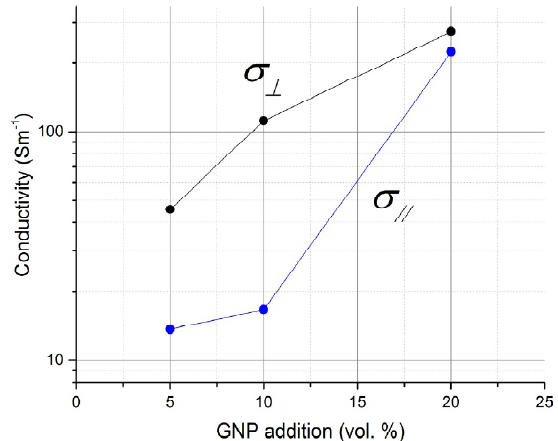
Fig. 7. Illustration of the electrical resistivity anisotropy in the 3YSZ-GNP composites with vary- ing Gr-addition contents, measurements at room temperature, image based on results reported in